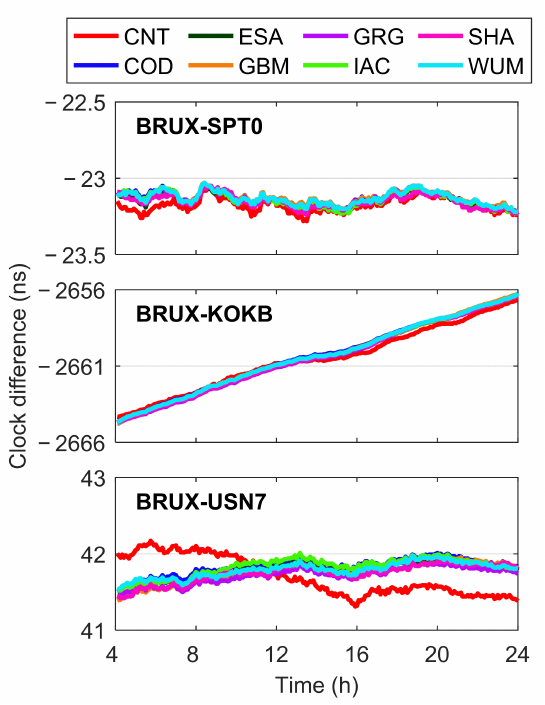
Figure 10. Three time links generated by Galileo five-frequency PPP using precise products from different ACs on DOY 248,